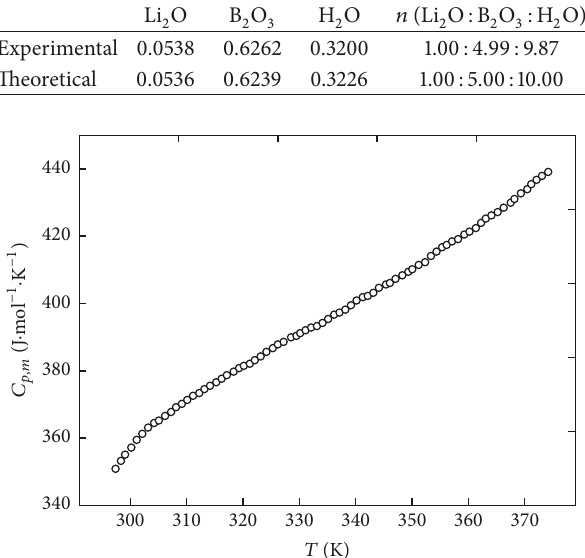
Figure 3: Experimental molar heat capacity of LiB 5 O 8 ⋅ 5H 2 O in the range of 297 to 375